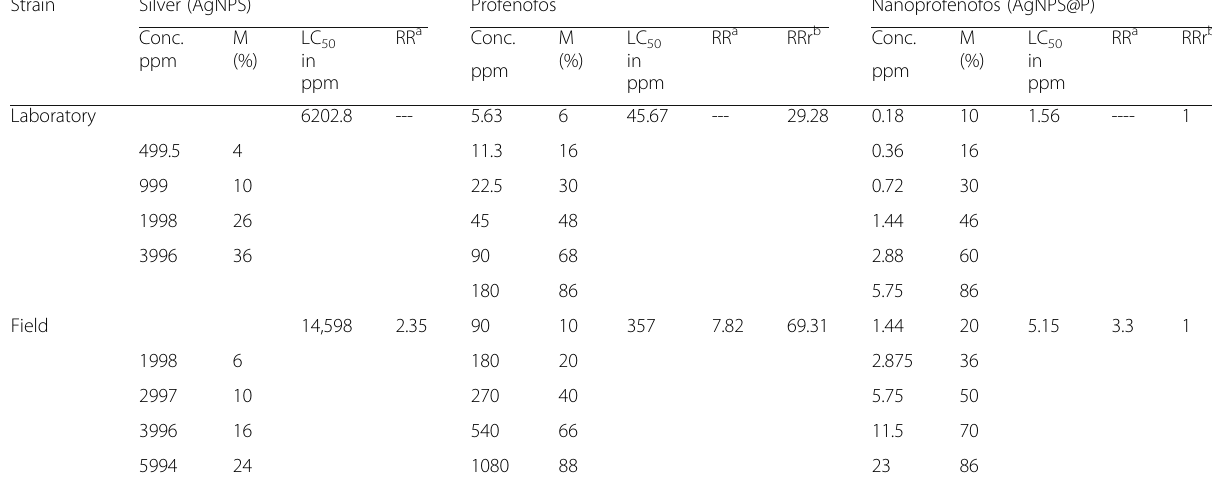
Table 2 Toxicity effect of silver nanoparticles (AgNPS) and profenofos compared with nanoprofenofos (AgNPS@P) against fourth- instar larvae of laboratory and field cotton leafworm, Spodoptera littoralis Strain Silver (AgNPS) Profenofos Nanoprofenofos (AgNPS@P) Conc.